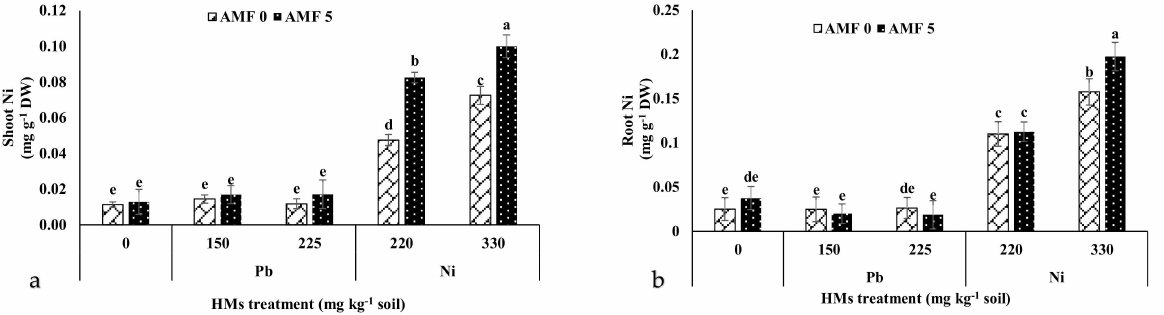
Figure 3. The effect of Pb and Ni (mg kg − 1 soil) heavy metal (HM) stress on the shoot ( a ) and root ( b ) Ni content of lavender plants inoculated with arbuscular mycorrhizal fungi (AMF). Different letters indicate significant differences according to the LSD test at p <